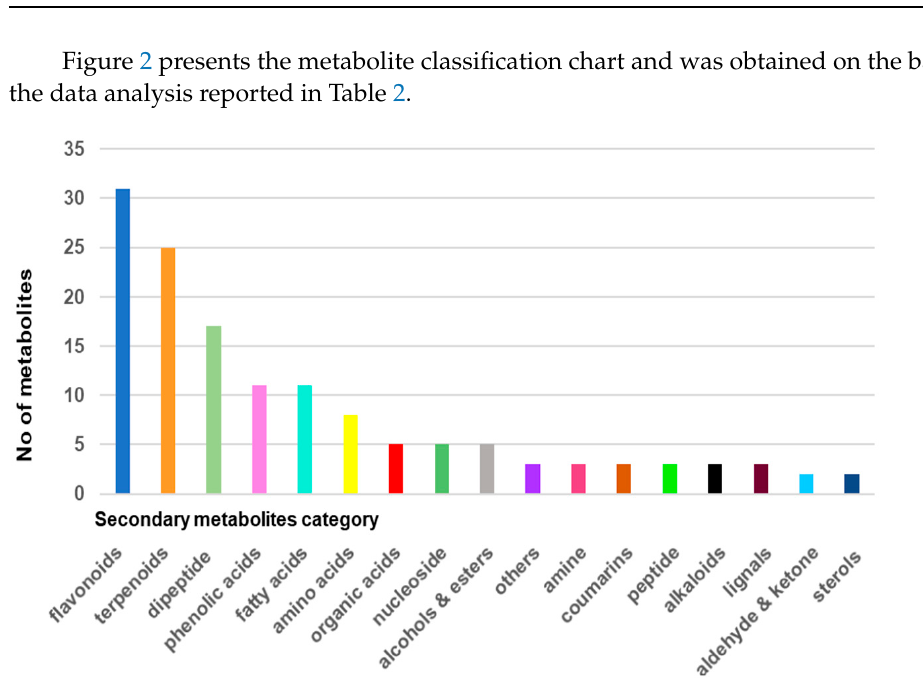
Figure 2. Metabolite classification bar chart of Romanian Viscum album hosted on Quercus robur L. (collected on summer solstice).